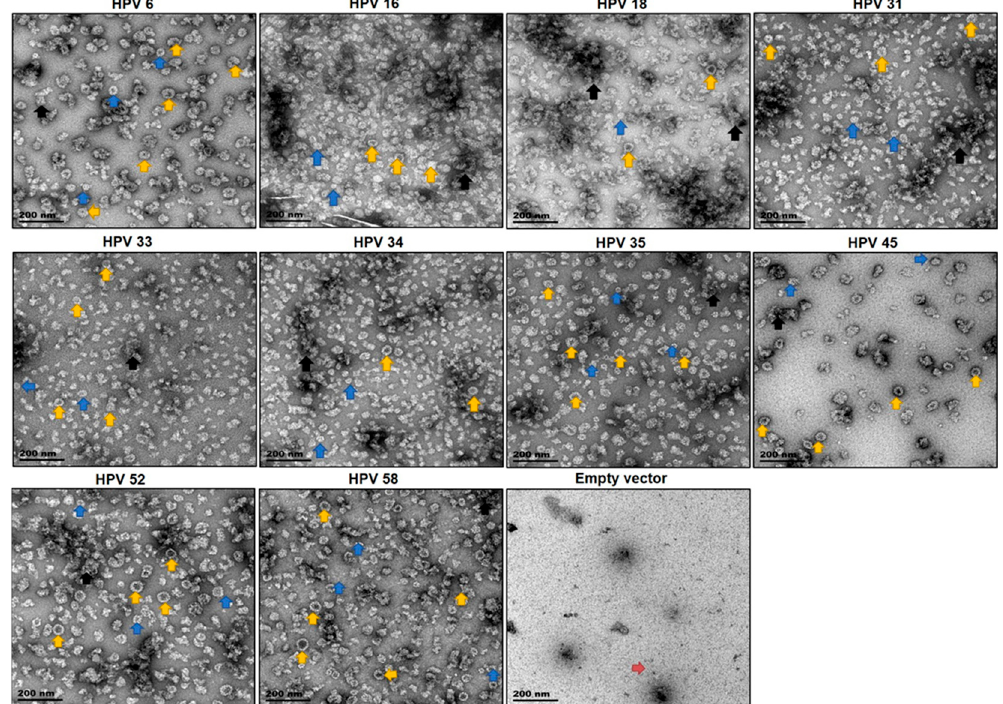
Figure 2. Transmission electron micrographs of purified VLPs. VLPs were purified on Optiprep™ density gradients and viewed under EM at a 40,000 × magnification. Scale bars are 200 nm in size. Arrows point to representative examples of VLPs (yellow arrows), small VLPs and / or capsomeres (blue arrows), L1 aggregates (black arrows), and native plant aggregates (red